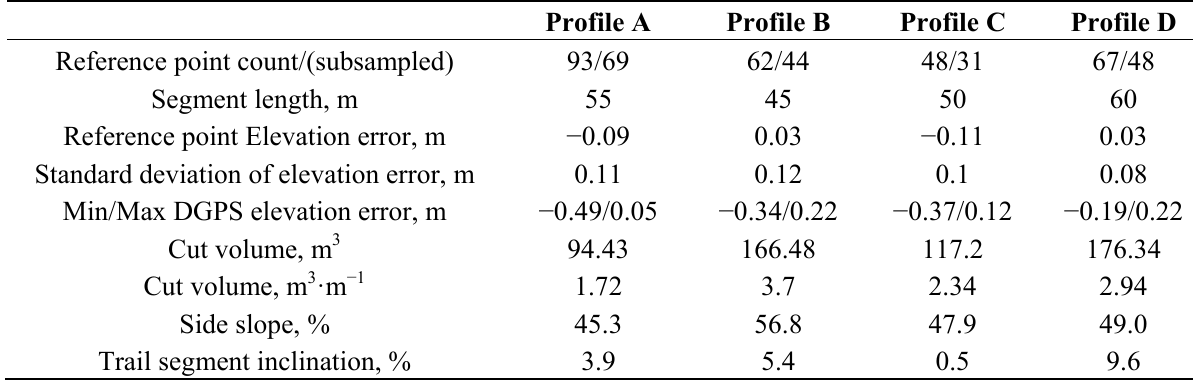
Table 2. Details on the road geometry and cut volumes, by